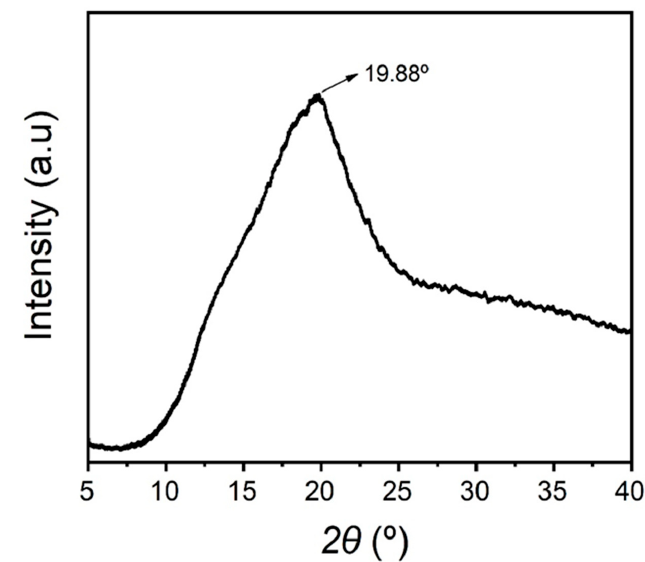
Figure 7. X ‐ ray diffractometry (XRD) of taro peel starch film. Figure 7. X-ray diffractometry (XRD) of taro peel starch